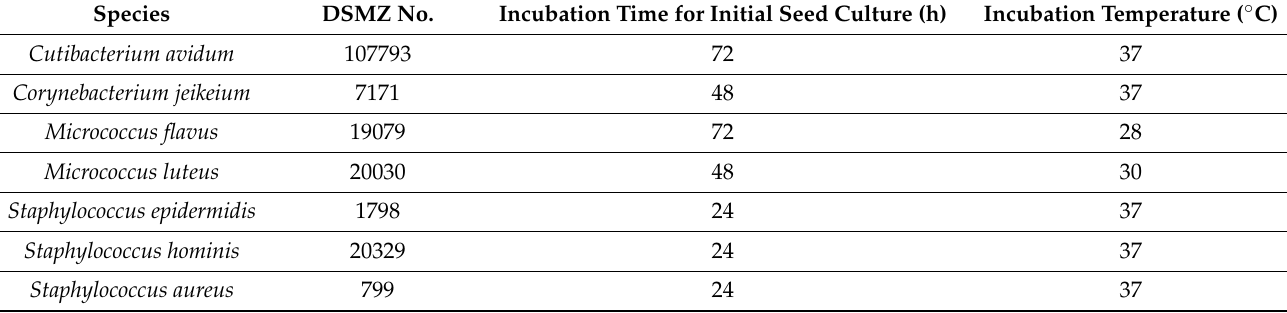
Table 1. Test strains and growth parameters.